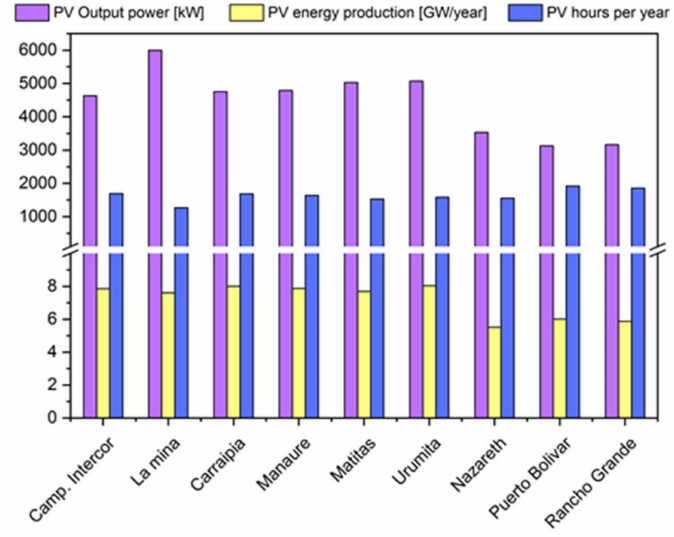
Figure 7. Comparison between the rated power and energy production for the photovoltaic (PV)